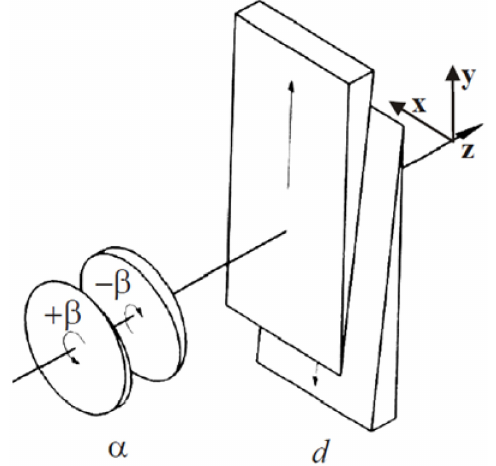
Fig. 7. Schematic drawing of the degrader system of the Fragment Separator [3].